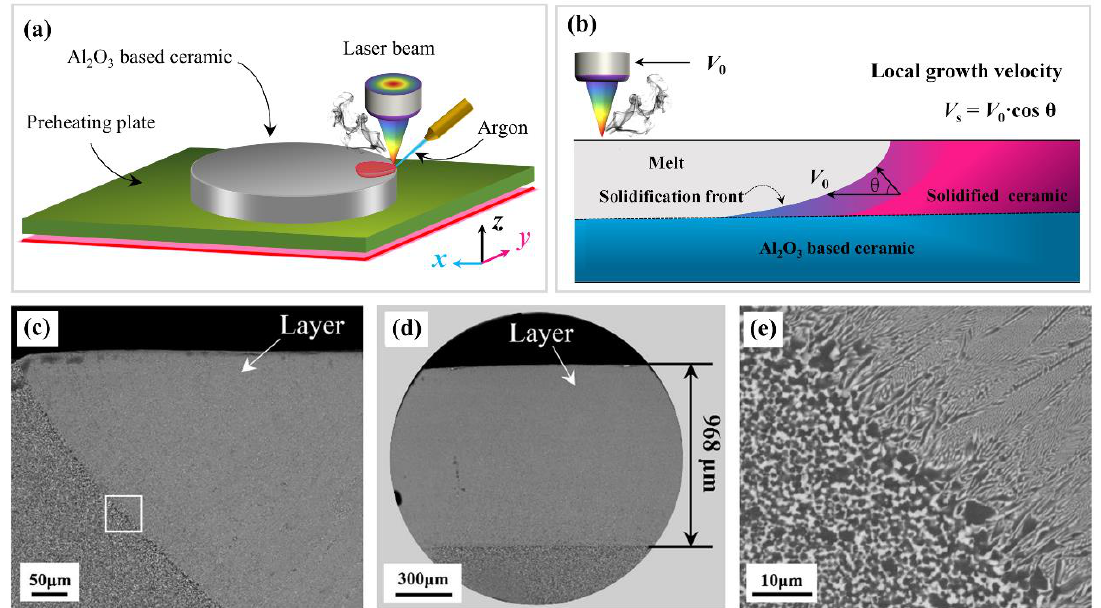
Figure 4. Schematic illustrations of ( a ) the setup for laser remelting and ( b ) the solidification process for surface nanostructuring of an Al 2 O 3 -ZrO 2 ceramic with a eutectic composition. The local growth rate ( V s ) is related to the laser scanning rate ( V 0 ) with the expression of V s = V 0 · cos θ , where θ is the tangent angle of the solidification front. Transverse cross-sections of nanostructured Al 2 O 3 -ZrO 2 eutectic layers via laser remelting at a heat input of 416.7 kJm − 1 ( c , d ) are different regions of a single laser-melted track. ( e ) The enlarged view of the square region marked in ( c ). Reproduced with permission from Reference [67], Copyright © 2019 Elsevier B.V.